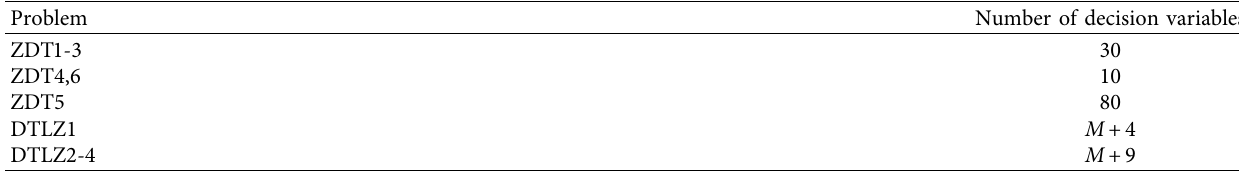
Table 1: Setting of decision variables.